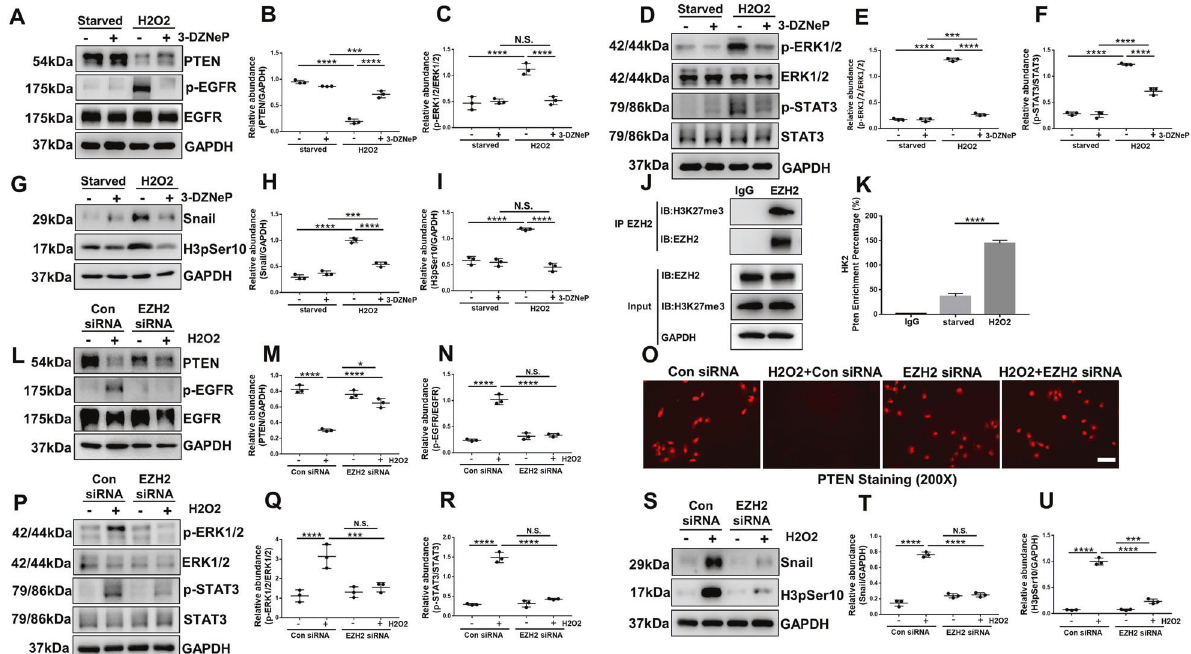
antibodies against PTEN, p-EGFR, EGFR, and GAPDH. B , C Expression levels of PTEN and p-EGFR were quanti fi ed by densitometry and normalized with GAPDH and EGFR, respectively. D Cell lysates treated with 3-DZNeP were subjected to immunoblotting analysis with antibodies against p-ERK1/2, ERK1/2, p-STAT3, STAT3, and GAPDH. E , F Expression levels of p-ERK1/2 and p-STAT3 were quanti fi ed by densitometry and normalized with ERK1/2 and STAT3, respectively. G Cell lysates treated with 3-DZNeP were subjected to immunoblotting analysis with antibodies against Snail, H3pSer10, and GAPDH. H , I Expression levels of Snail and H3pSer10 were quanti fi ed by densitometry and normalized with GAPDH. J 0.5 mM H 2 O 2 -treated HK2 cell lysates were subjected to immunoprecipitation with IgG or EZH2 antibody, followed by EZH2 and H3K27me3 immunoblotting. K Content of PTEN promoter enriched by IgG or H3K27me3 antibody in HK2 cells treated with or without 0.5 mM H 2 O 2 by CUT & TAG analysis. L Cell lysates transfected with EZH2 siRNA were subjected to immunoblotting analysis with antibodies against PTEN, p-EGFR, EGFR, and GAPDH. M , N Expression levels of PTEN and p-EGFR were quanti fi ed by densitometry and normalized with GAPDH and EGFR respectively. O Photomicrographs showed the immuno fl uorescent staining of PTEN in the HK2 of each group. P Cell lysates transfected with EZH2 siRNA were subjected to immunoblotting analysis with antibodies against p-ERK1/2, ERK1/2, p- STAT3, STAT3, and GAPDH. Q , R Expression levels of p-ERK1/2 and p-STAT3 were quanti fi ed by densitometry and normalized with ERK1/2 and STAT3, respectively. S Cell lysates transfected with EZH2 siRNA were subjected to immunoblotting analysis with antibodies against Snail, H3pSer10, and GAPDH. T , U Expression levels of Snail and H3pSer10 were quanti fi ed by densitometry and normalized with GAPDH. Data